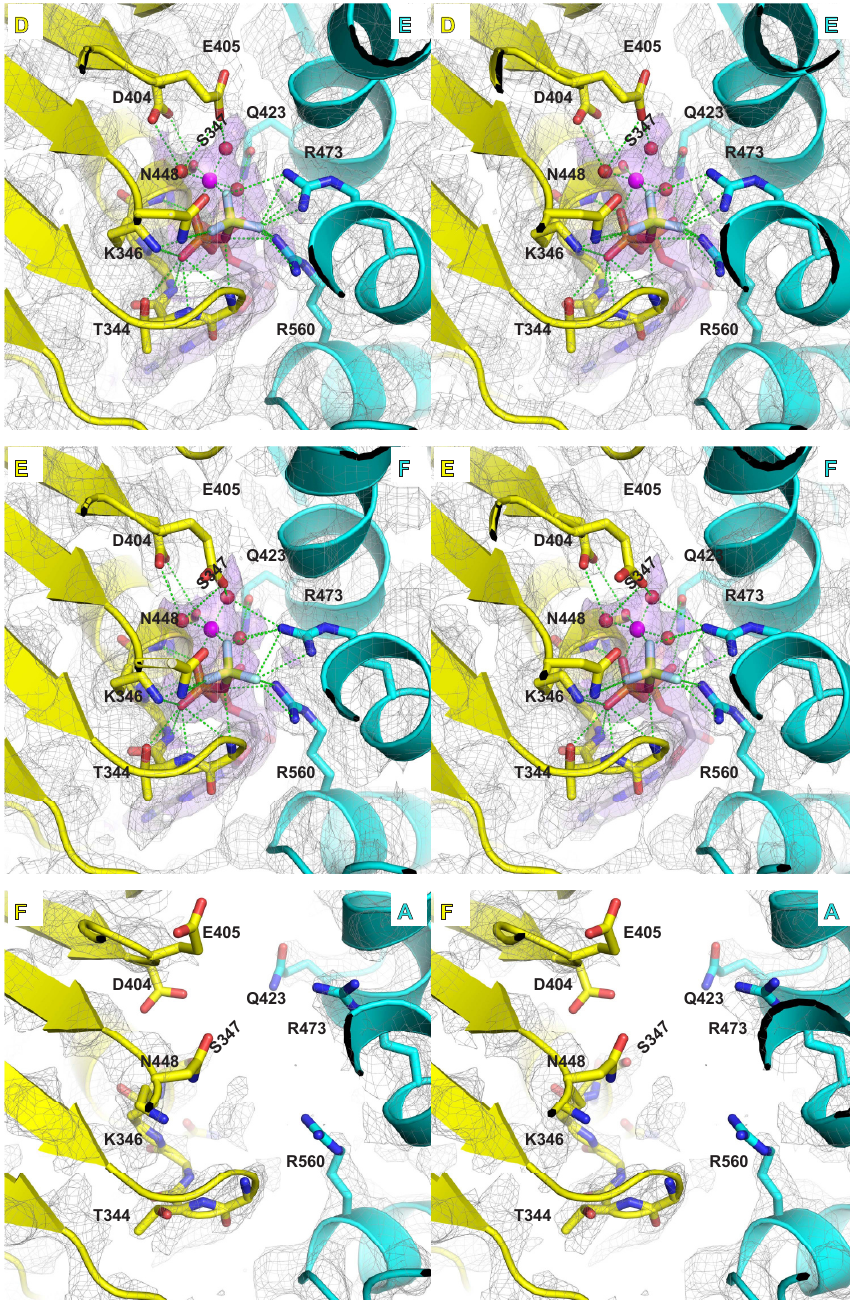
Figure 4. Stereoviews of the six subunit interfaces of class 1 illustrating the Mg/ATPase sites. The specific subunits comprising the interfaces are indicated by their chain identifiers (A,B,C,D,E,F). The illustrated maps and models were obtained by refinement of the merged particles of class 1 obtained for three different oligonucleotides (see Figures S10A, S11A and S12A). For each view, the subunit containing the Walker-A and -B residues is depicted in yellow, and the neighboring subunit with the arginine finger is depicted in cyan. Density above 5.0-sigma is shown in grey mesh with density within 2.5 Å of the modeled Mg/ATP also illustrated in purple transparent surface. Five interfaces show strong nucleotide density that do not strongly differ from each other. The sixth interface (F/A) is more open and does not show significant nucleotide density. Interactions involving Mg/ATP are depicted with green dashes. Interacting sidechains are shown in stick and labeled: T344, K346, and S347 of Walker-A; D404 and E405 of Walker-B; N448 of Sensor-1; R560 of Sensor-2; R473 arginine finger; and Q423. The magnesium ion in magenta has an octahedral coordination sphere derived from an oxygen of the β -phosphate, a fluoride of the BeF 3 moiety, the conserved oxygen sidechain